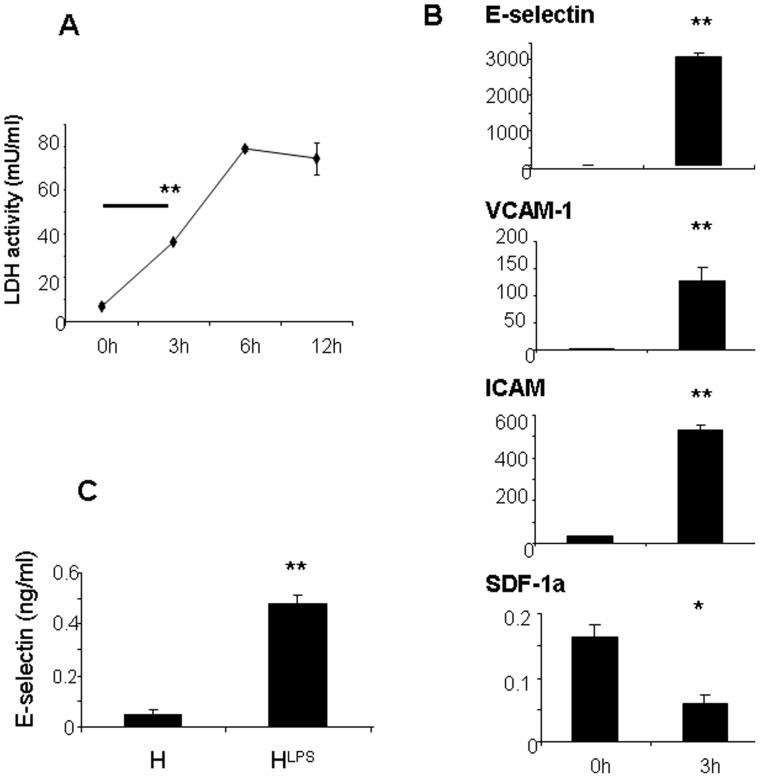
E-selectin, VCAM-1 and ICAM-1 expression is increased in LPS-treated HUVEC cells.
A) LPS-treated HUVEC cells demonstrate significant cellular injury and increased lactate dehydrogenase (LDH) after 3h (** p<0.01). B) Gene expression of E-selectin, VCAM-1, ICAM-1 and SDF-1α induced in HUVECs after endotoxic injury was determined by RT-PCR relative to GAPDH expression (* denotes p<0.05 and ** p<0.01 in comparison with baseline). C) E-selectin levels after 12 hours in conditioned media from LPS-treated HUVEC cells (HLPS) compared with ECFCs exposed to conditioned media from control HUVEC cells (H) or LPS-treated HUVECs cultured in the presence of anti-CD62E which inhibits soluble E-selectin (H+anti-CD62E)LPS, as measured using ELISA.(** p<0.01)